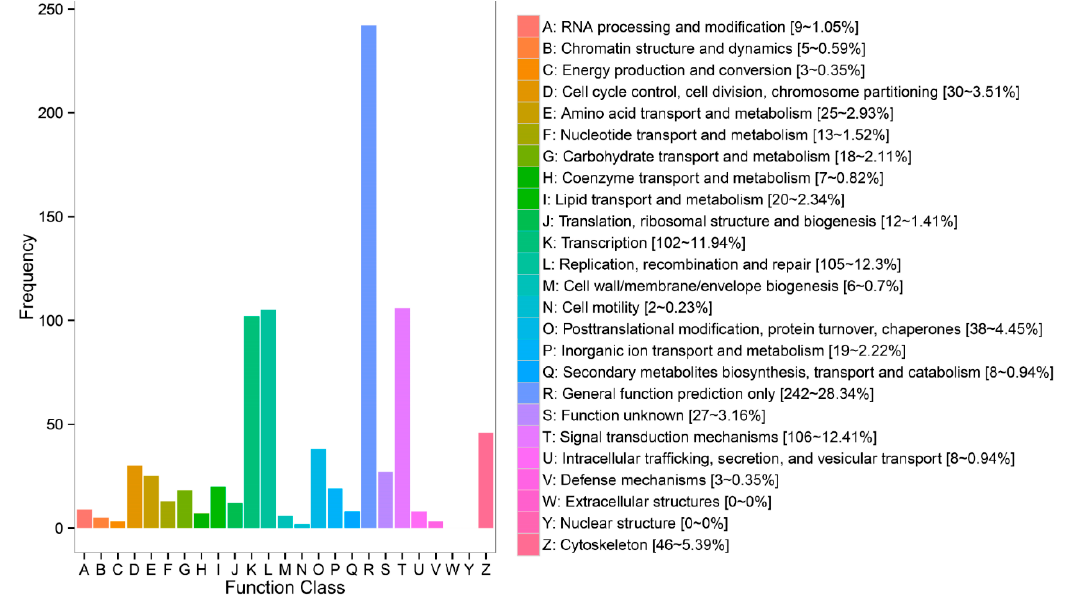
Figure 8. Clusters of orthologous groups (COG) classification; 541 testes-biased genes with Nr hits were grouped into 23 COG classifications.